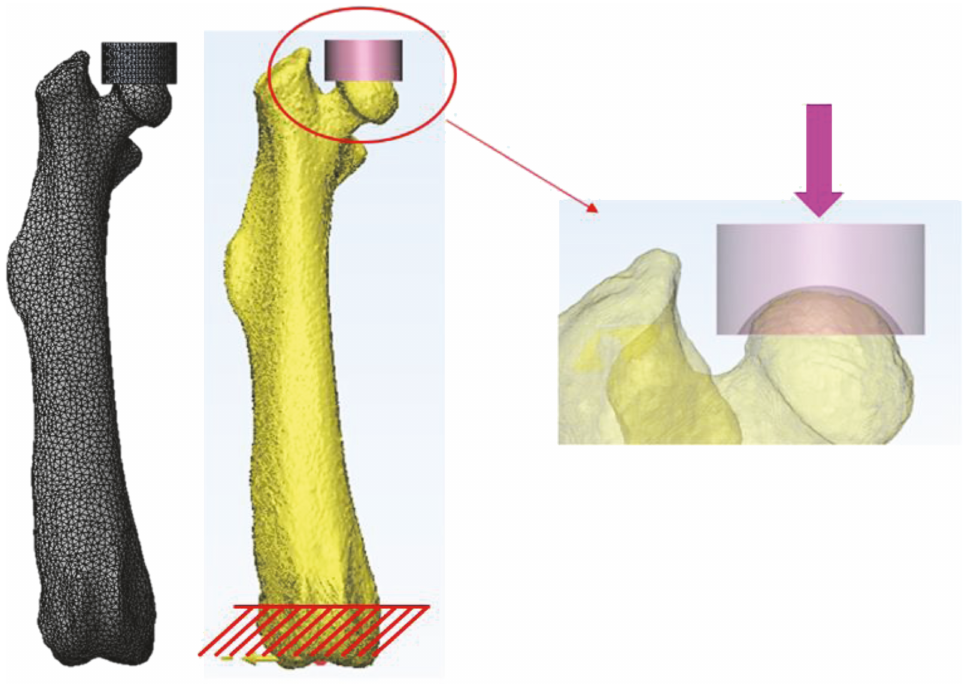
Figure 6: Load and boundary conditions for fi nite element